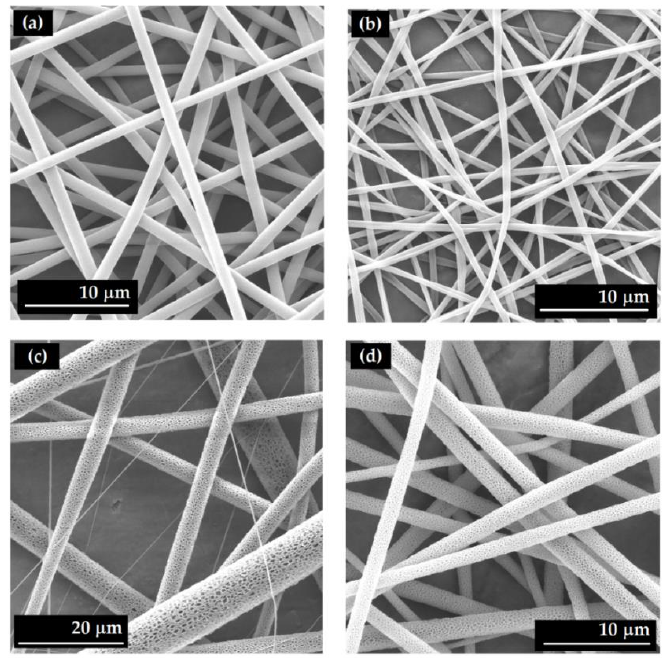
Figure 4. SEM images of fibers electrospun from PLA solutions using different solvents of ( a ) HFIP (unpublished original picture by the authors), ( b ) TFE (unpublished original picture by the authors), ( c ) CHCl 3 (unpublished original picture by the authors), ( d ) DCM (unpublished original picture by the authors).